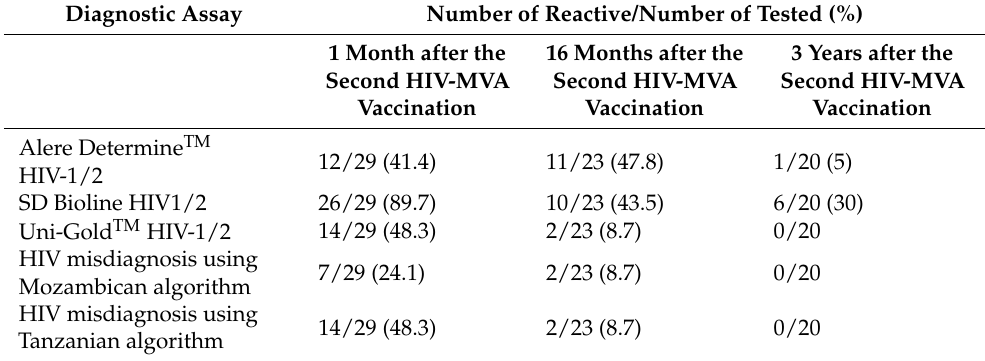
Table 2. Frequency of VISR and HIV status misclassifications at one month, sixteen months and three years after the last HIV-MVA